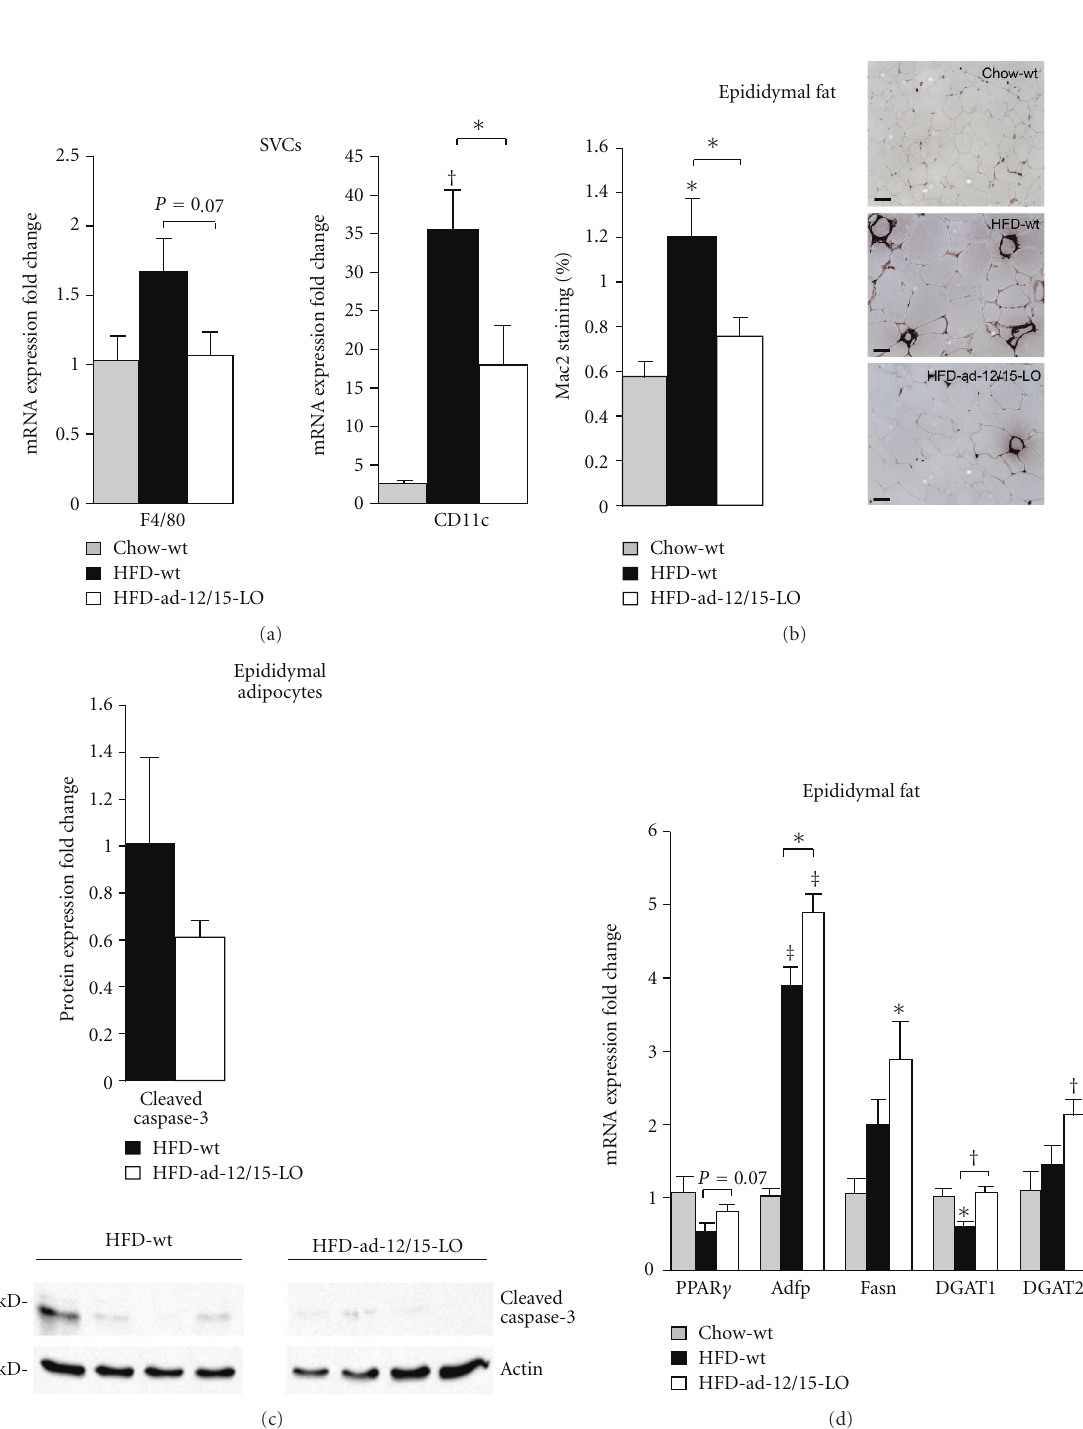
Figure 4: Adipose tissue from fat-specific 12/15-LO-deficient mice exhibits decreased macrophage infiltration and may be more adipogenic and lipogenic. (a) mRNA expression of key macrophage markers was measured by RT-PCR in stromal vascular cells (SVCs) isolated from epididymal adipose tissue. (b) Immunohistochemistry for Mac2 expression was performed in epididymal adipose tissue, and Mac2 staining was quantified. Scale bar = 50 μ M. (c) Protein measurements of cleaved caspase-3 were performed from isolated epididymal adipocytes and quantified. Representative western blots are shown, and separate panels for each antibody represent the same exposure from the same gel. (d) mRNA measurements of key adipogenic and lipogenic genes were examined by RT-PCR in epididymal adipose tissue from mice. All mRNA and protein data were normalized to total actin, and the fold changes in expression were calculated relative to control. All data represent the means ± SEM; n = 3–6. ∗ P < 0 . 05, † P < 0 . 02, ‡ P < 0 . 001 versus control, unless otherwise indicated. Chow: chow diet; HFD: high-fat diet; wt: wild type 12/15 - LO loxP/loxP